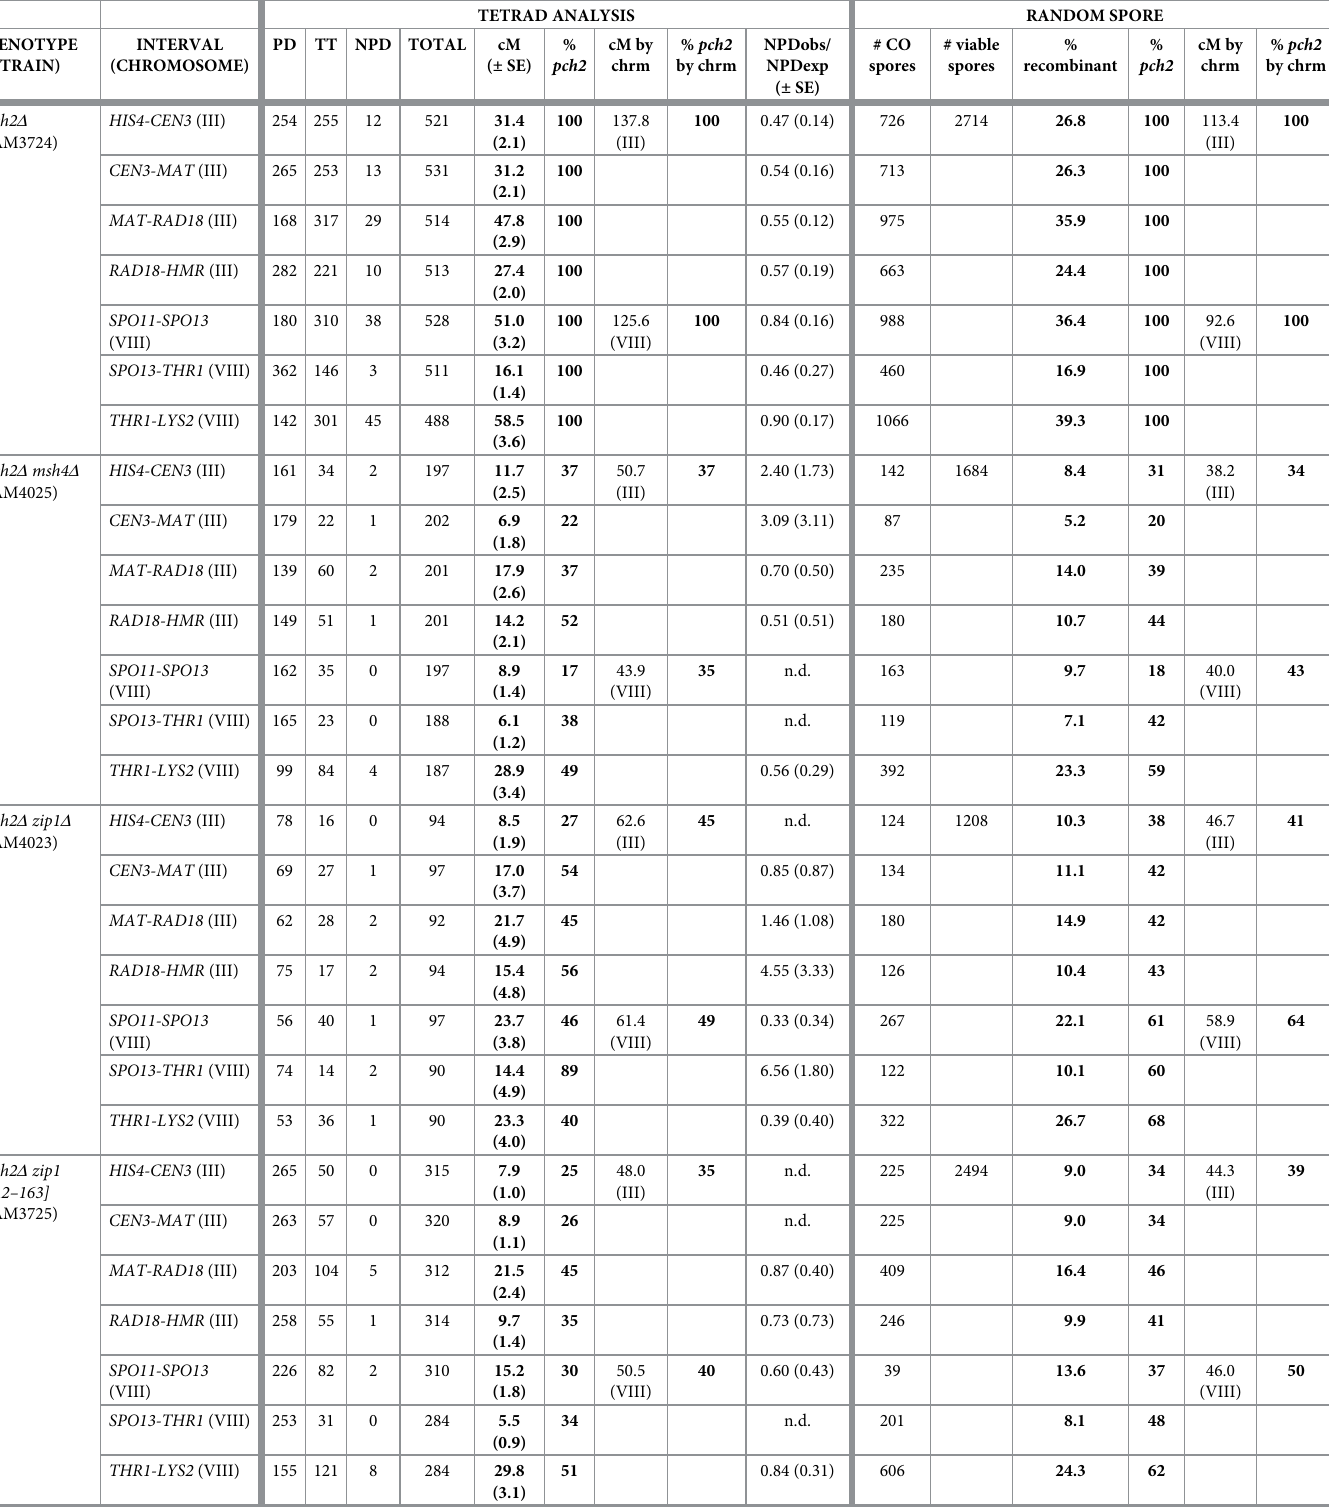
Table 1. Genetic map distances in mutant strains; pch2 background. TETRAD ANALYSIS RANDOM